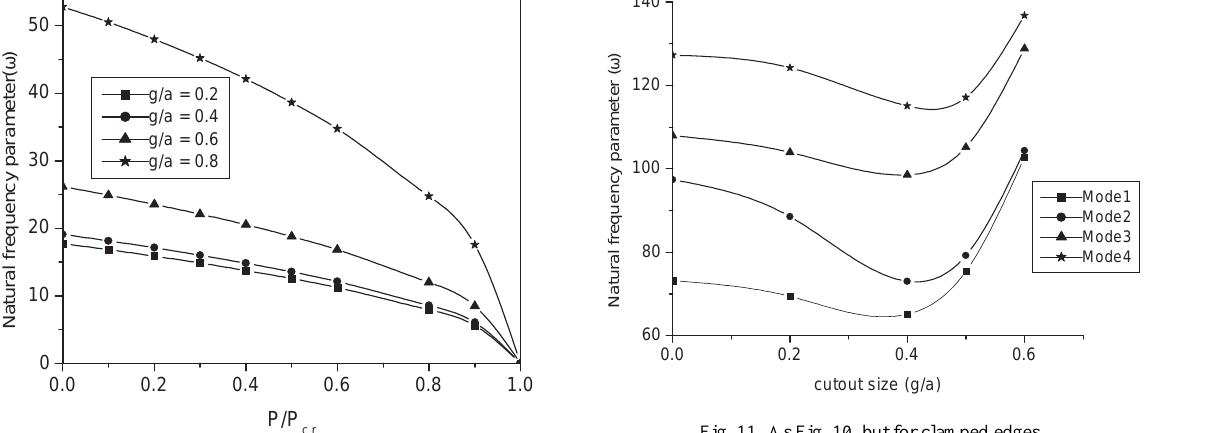
Fig. 11. As Fig. 10, but for clamped